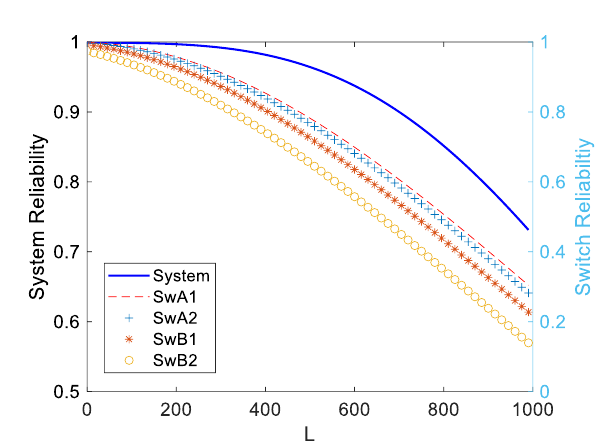
Figure 12. Set 1 in Table 10 ( L SwA10 = 30 , L SwA20 = 50, L SwB10 = 100, and L SwB20 = 180 and α= 2.0).